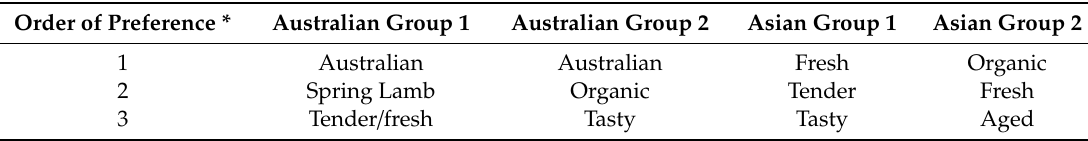
Table 2. Top three product descriptors selected by the panel in order of preference, (selected from 28) descriptors for